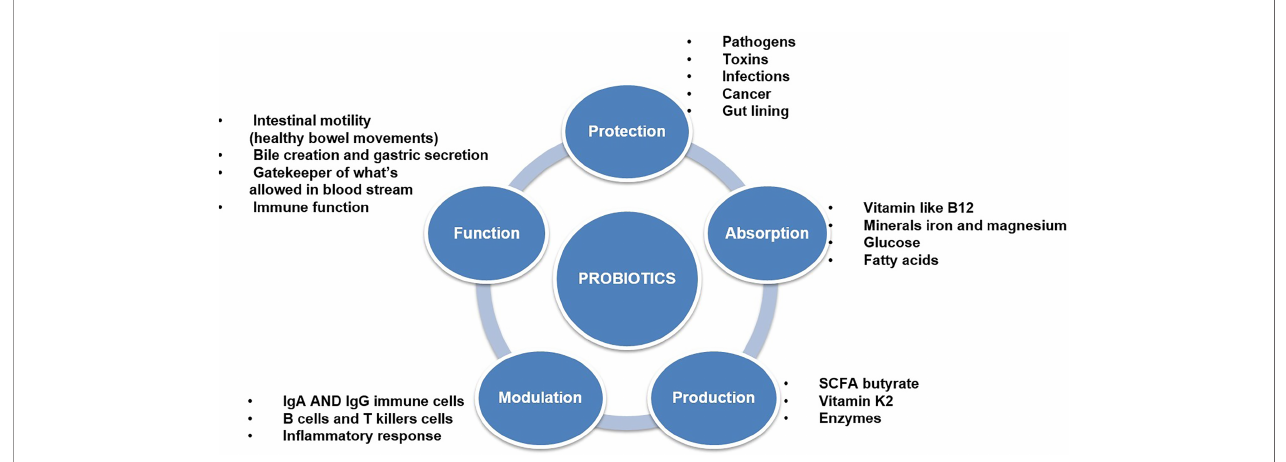
FIGURE 3 | Ef fi cacy of probiotics and different types of functional